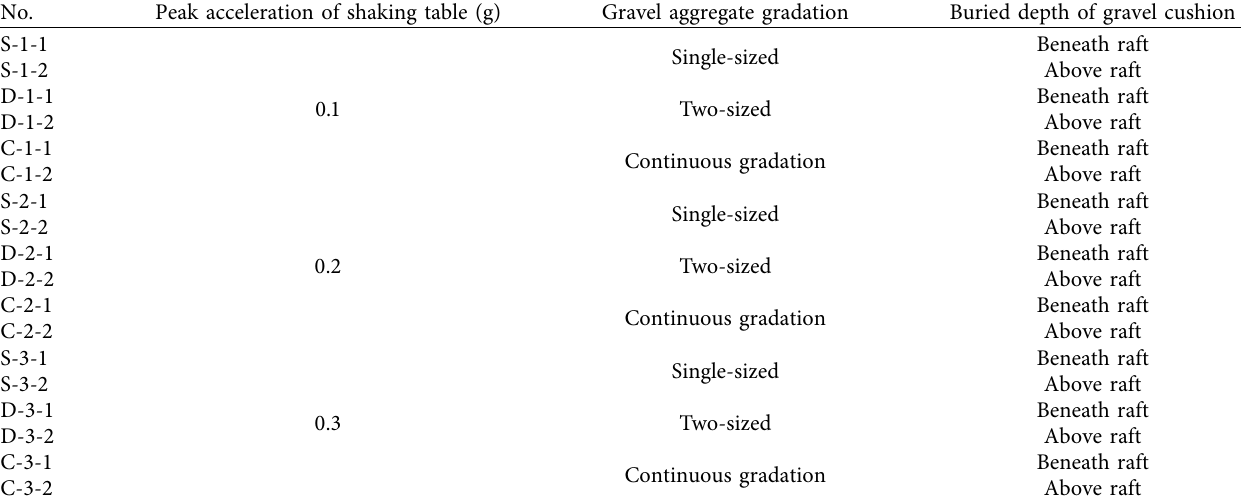
Figure 7: Test model construction procedure. (a) Clay casting. (b) Holes reserved for mounting piles. (c) Gravel, superstructure—raft. (d) Completed model. Table 3: Parameter settings for shaking table tests (El Centro seismic